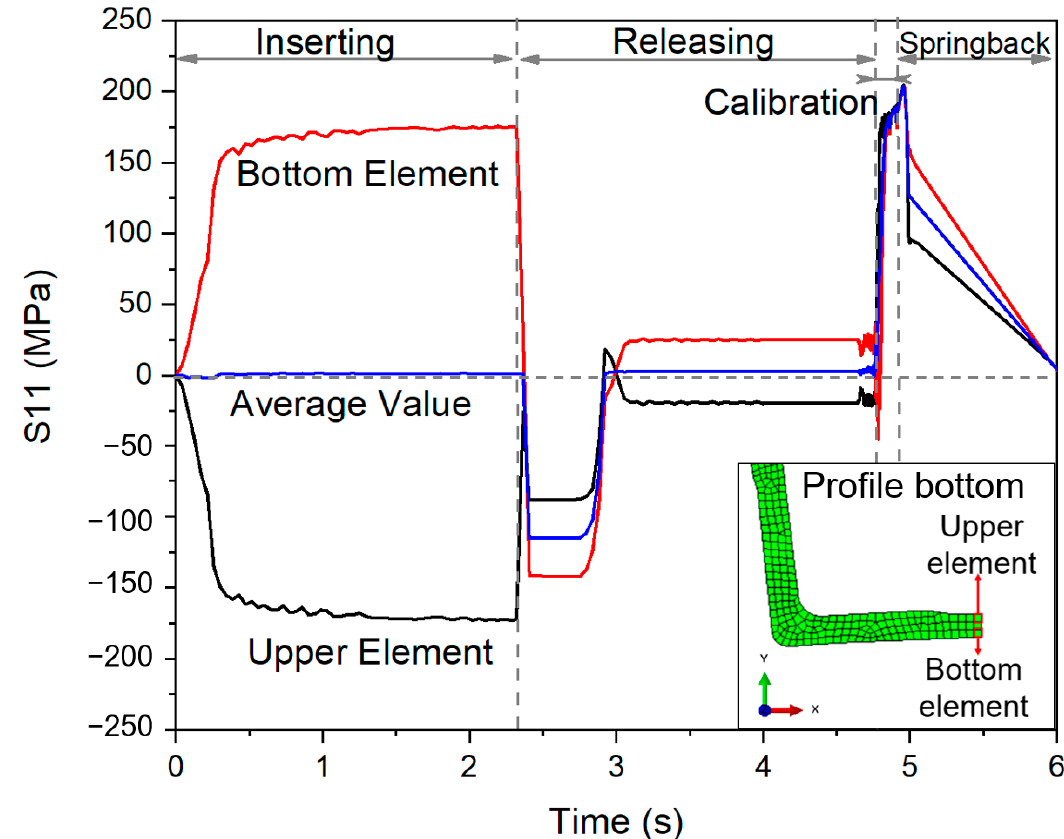
Figure 9. S11 evolution of two elements on the profile bottom during the whole TSLB process.